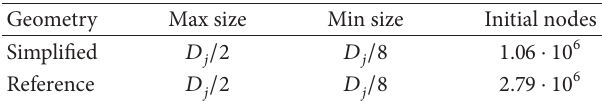
Table 2: Main features of the computational grids before VOF